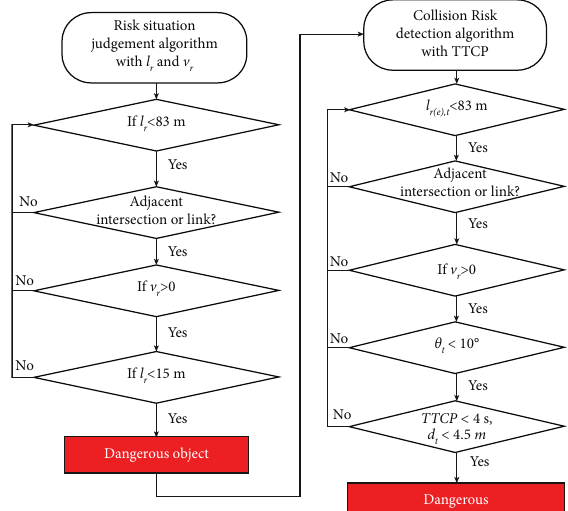
Figure 3: Risk detection algorithm with